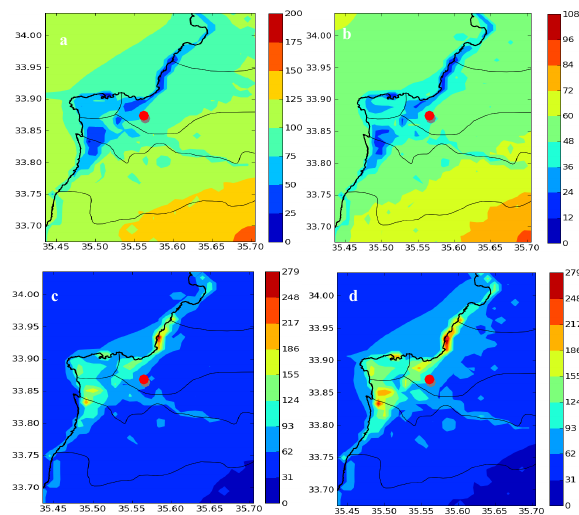
Figure 3. Modeled average O 3 concentrations ((a) simulation A1 and (b) simulation A4) and 2 Fig. 3. Modeled average O 3 concentrations ( (a) simulation A1 and NO 2 concentrations ((c) simulation A1 and (d) simulation A4) in µg/m 3 for the outer domain 3 (b) simulation A4) and NO 2 concentrations ( (c) simulation A1 and D2 ( T = Tripoli; C = Chekka ; B = Beirut; J = Jieh). 4 (d) simulation A4) in µgm − 3 for the outer domain D2 (T = Tripoli; C = Chekka; B = Beirut; J = Jieh).